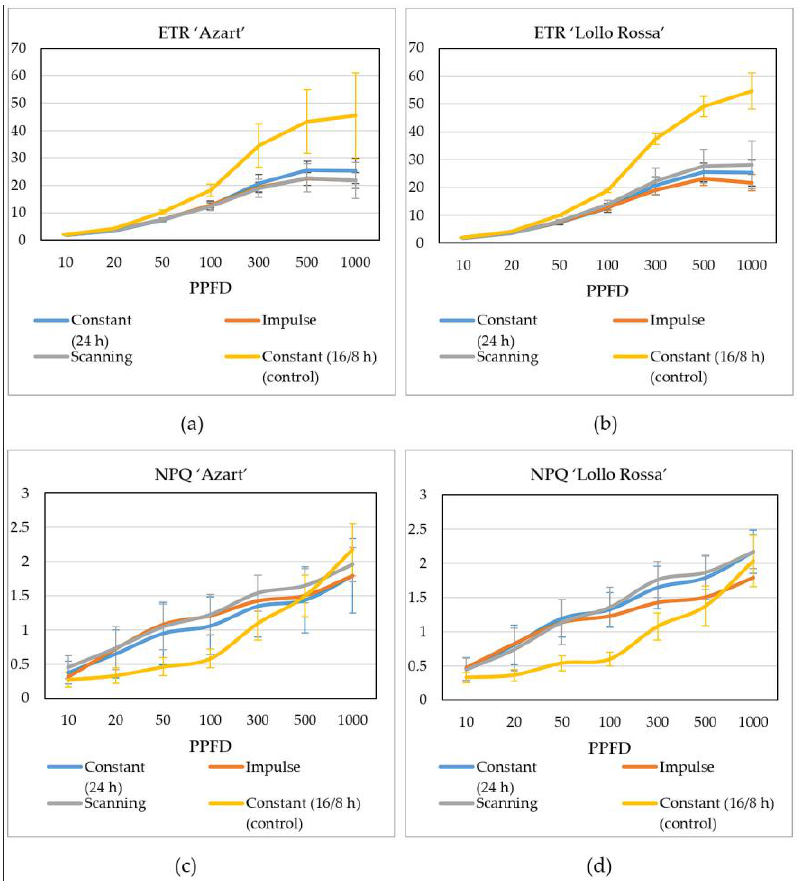
Figure 4. Dependence of the rate of electron transport ( a , b ) and non-photochemical ( c , d ) quenching of chlorophyll fluorescence on PPFD of lettuce plants on the 35th day of cultivation. Values represent mean SEM (n = 6).